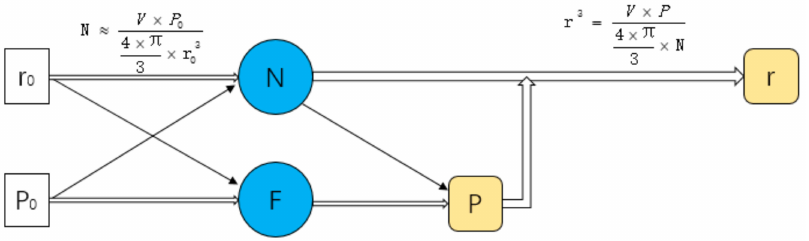
Figure 18. The relationship of the parameters.